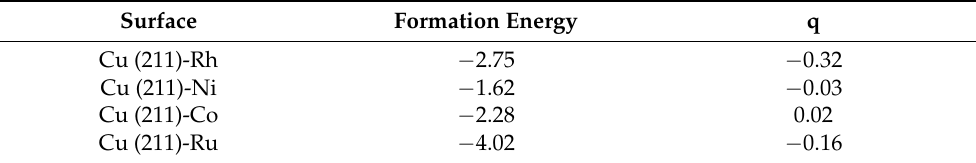
Table 1. Formation energies (eV) and Bader charges (q, e) of transition-metal-doped Cu(211)-M (M = Rh, Ni, Co, Ru) surfaces.